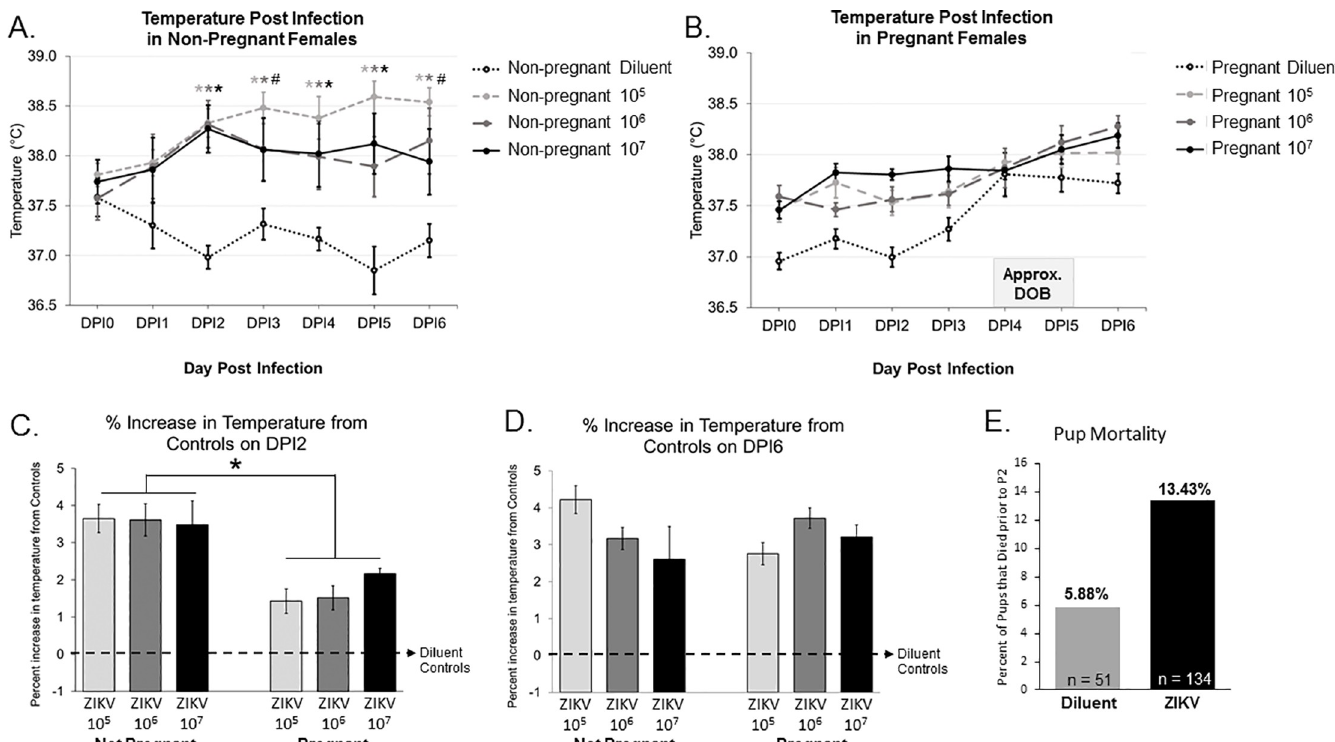
Fig 1. Examination of febrile response following ZIKV inoculation. ( A ) In non-pregnant females, there was a significant Treatment x Day interaction (F 12.141, 72.844 = 4.378, p < 0.001). Post hoc comparisons revealed that by DPI2 all three non-pregnant ZIKV infected groups had a significantly higher temperature compared to the non-pregnant diluent treated groups (10 5 : P < 0.001; 10 6 : P < 0.001; 10 7 : P < 0.001), and that this effect persisted until six days following injection (DPI6) (10 5 : P = 0.001; 10 6 : P = 0.009; 10 7 : P = 0.068). ( B ) In the pregnant females, statistical analysis revealed a main effect of day (F 4.473, 134.176 = 19.665, p < 0.001) and no interaction with ZIKV inoculation. ( C ) Percent increase in body temperature from diluent treated controls was analyzed on DPI2, and this analysis revealed a significant main effect of pregnancy condition on DPI2 (F 1,42 = 38.07, P < 0.001). n = 4–13 animals per group. ( D ) Percent increase in body temperature from diluent treated controls was analyzed on DPI6, this analysis revealed no significant difference between groups. ( E ) Neonatal mortality was not significantly different between the diluent treated group 5.88% (n = 51) and the ZIKV group 13.43% (n = 134) ( Χ 2 = 2.093; p = 0.148). � : p < 0.05.